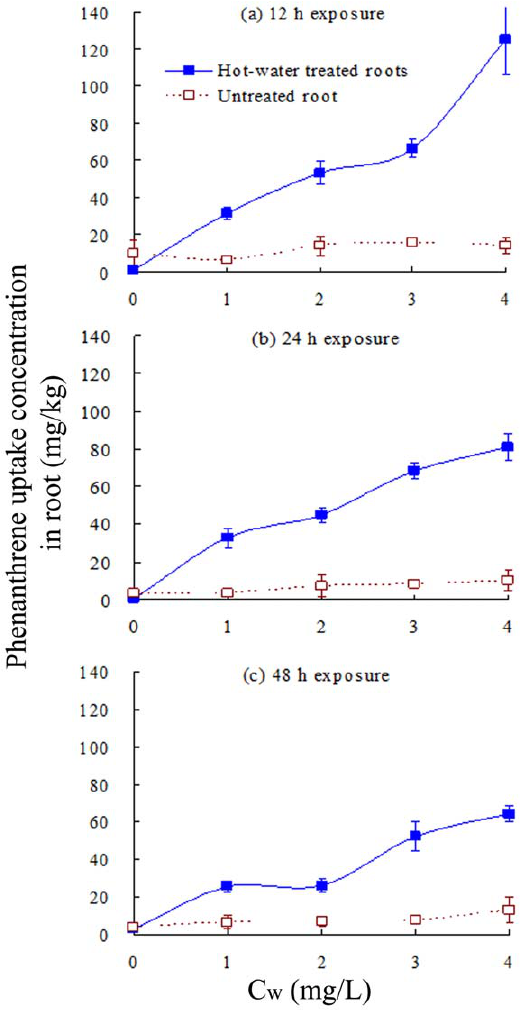
Figure 7. Phenanthrene uptake ( mg/kg ) in tall fescue roots treated by immersion in 100 6 C water for 5 min, compared to the control. Plant roots were exposed to phenanthrene at initial concentrations of 0–4 mg/L in aqueous solution and sampled after (a) 12 h, (b) 24 h, and (c) 48 h. Error bars represent standard deviations